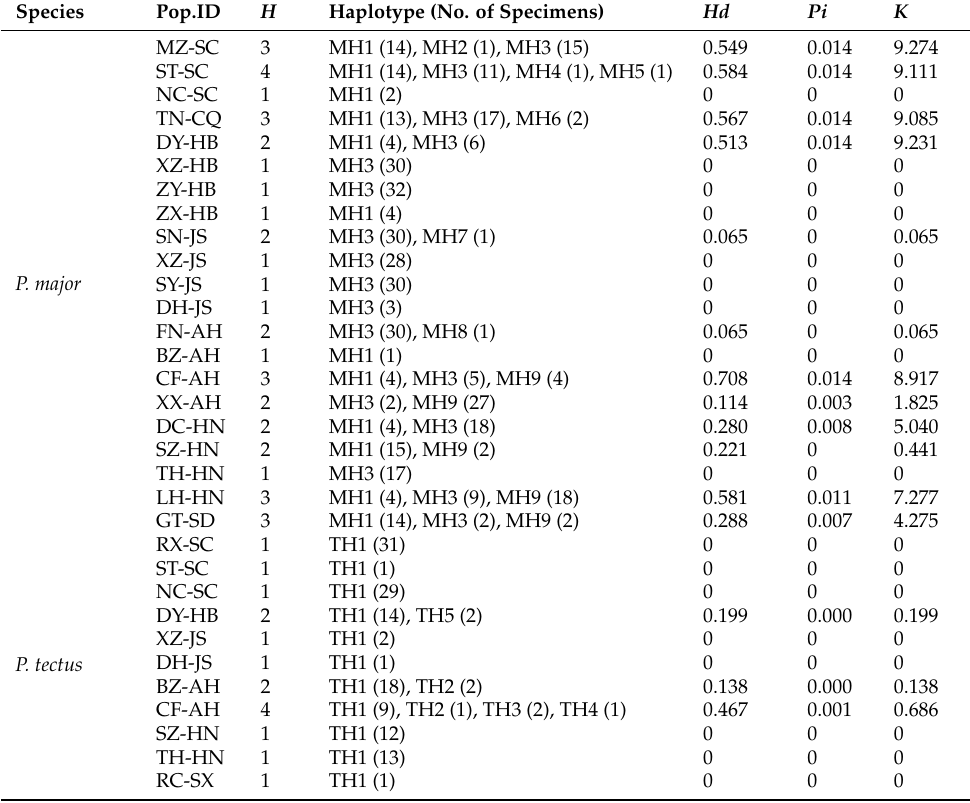
Table 3. Genetic diversity of P. major and P. tectus from different locations based on mitochondrial COI gene. Species